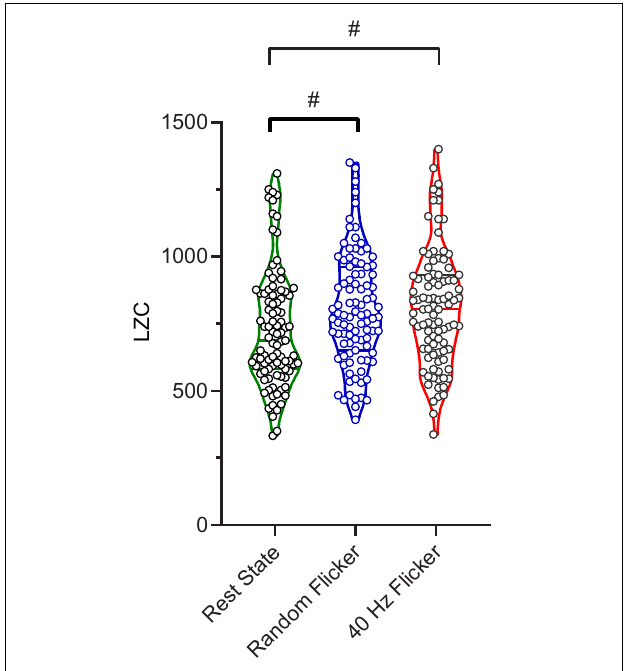
FIGURE 5 | Microstate LZC. Microstate LZC under rest state, random light flicker, and 40 Hz light flicker exposure. LZC of microstate transitioning was computed for epochs with identical lengths under different conditions. Each dot referred to a single epoch during the experiment. # indicated P < 0.05 using one-way ANOVA with FDR post hoc